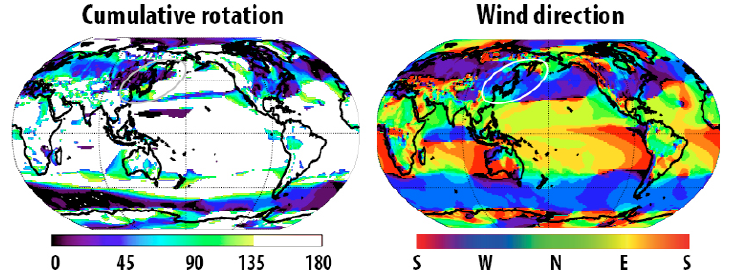
Figure 8. Cumulative rotation of wind from 975 to 30hPa (left) and prevailing wind direction st 975hPa (right). Computed from JRA-55 for November